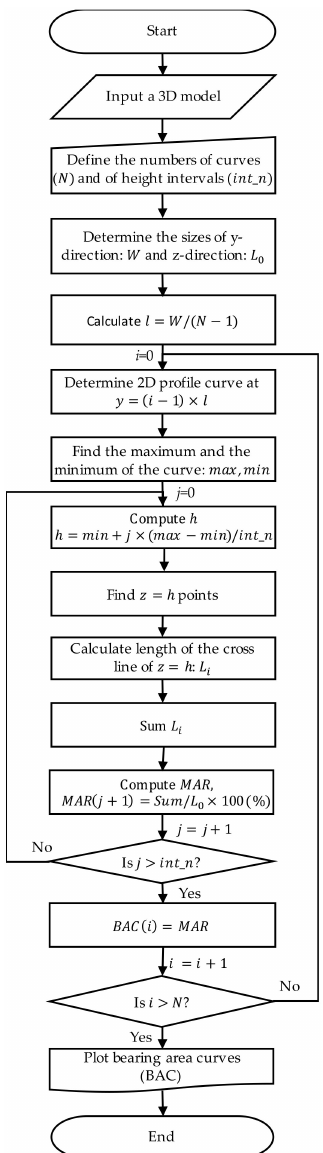
Figure 7. Flow chart for determining bearing area curve (BAC). MAR denotes material area